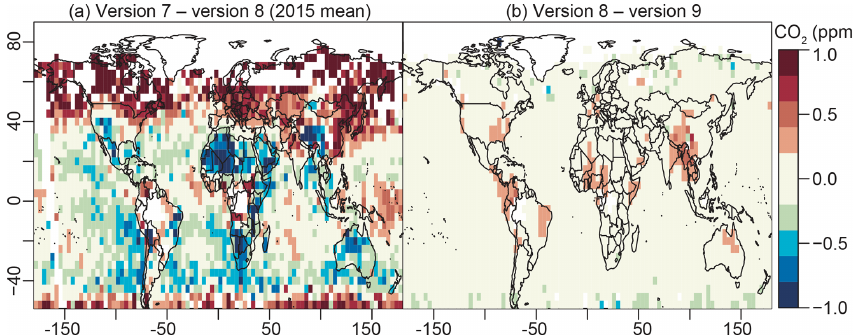
Figure 1. Differences between versions 7 and 8 of the OCO-2 observations (a) and between versions 8 and 9 of the observations (b) . Version 8 was a much larger update to the observations than version 9. We average all of the differences between observations onto a grid to make the differences more visually apparent. The results shown here are for observations collected in 2015, the time period analyzed in this study. In addition, this map only displays grid boxes with more than 250 total observations in